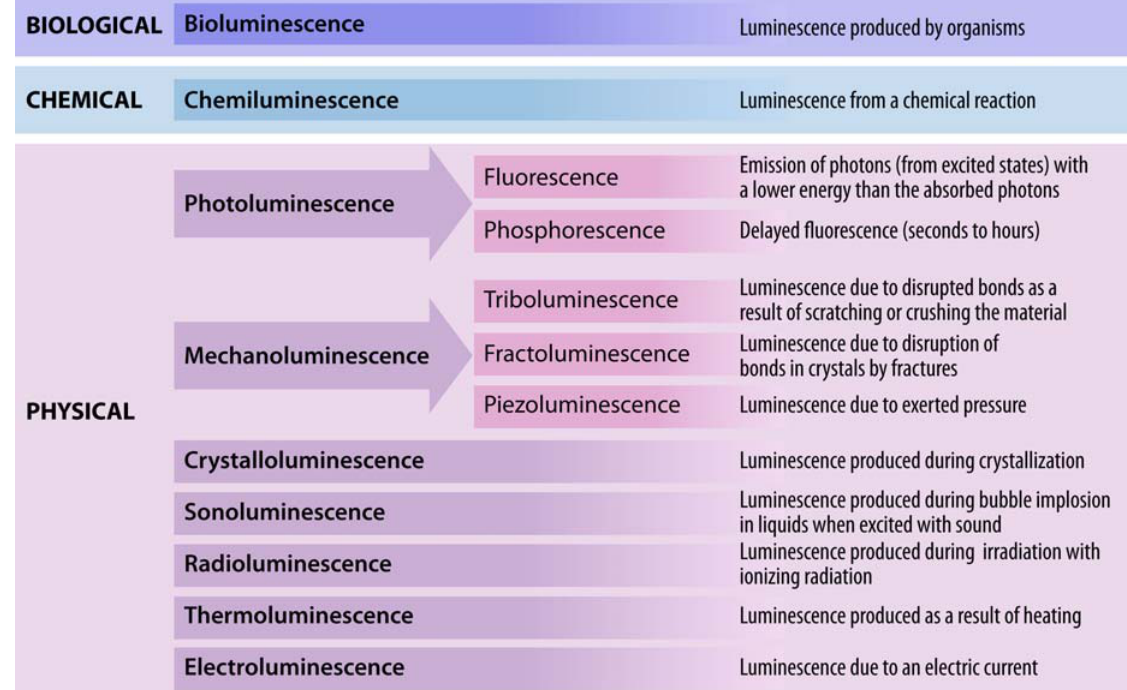
Table 1. Overview of various luminescent